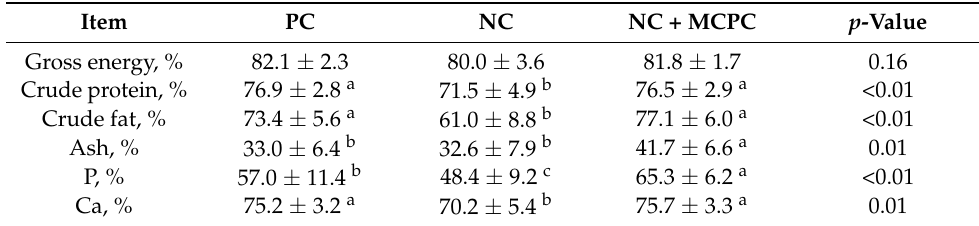
Table 4. Effect of multicarbohydrase and phytase complex on the apparent total tract digestibility of gross energy (GE), crude protein, crude fat, ash, P, and Ca of pigs 1 .